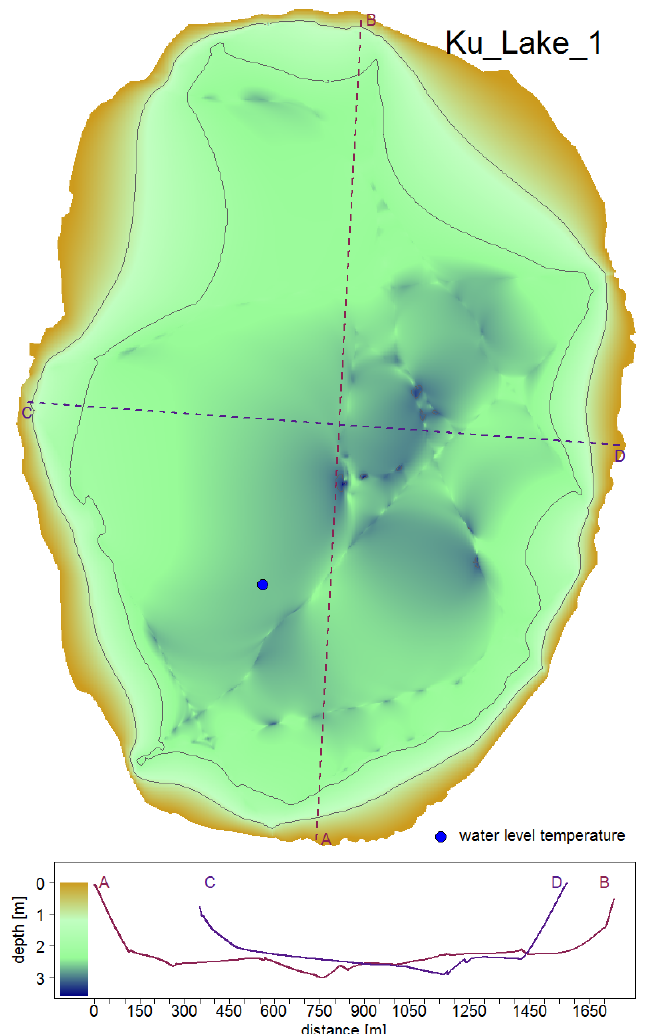
Figure A5. Bathymetry and cross sections of Ku_Lake_1. Data from Morgenstern et al. (2011) and